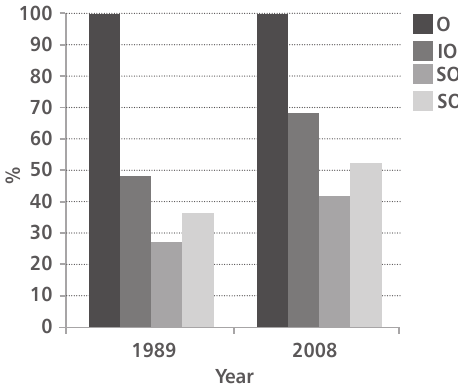
FIGURE 3. Comparison of pedunculate oak da- mage indicators for two surveying periods